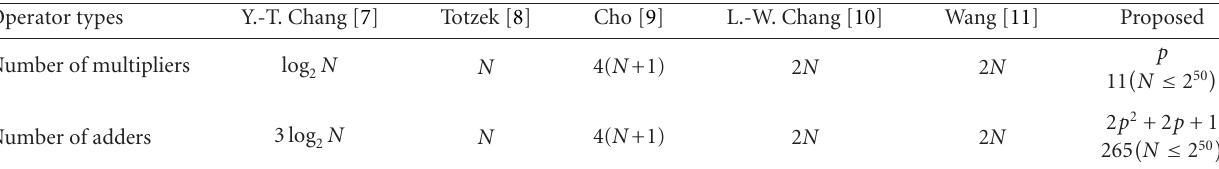
Table 1: Comparison of some systolic arrays for N -point